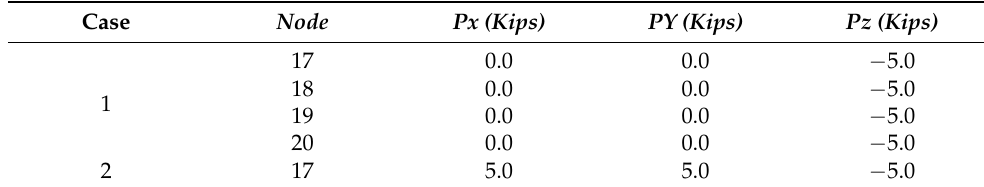
Figure 12. The construction of the 72-bar truss design problem. ( a ) The front view; ( b ) Structure diagram in 3-dimension. Table 10. Multiple loading conditions for the 72-bar truss.